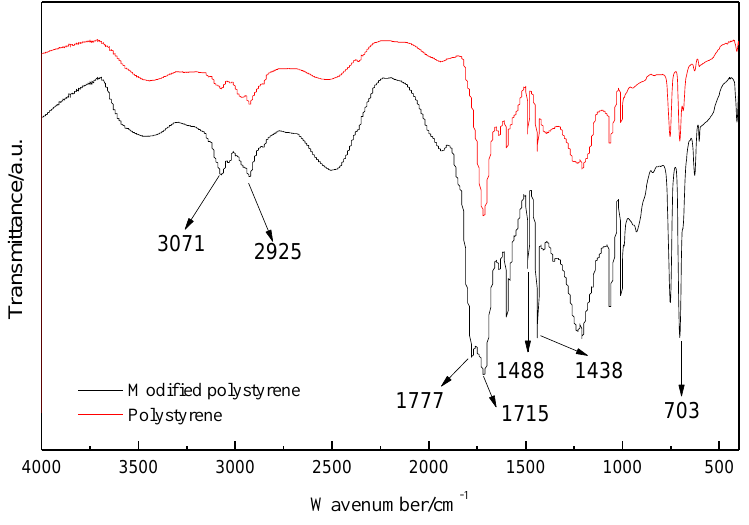
Figure 3. FT−IR spectrum analysis of modified polystyrene. Figure 3. FT − IR spectrum analysis of modified